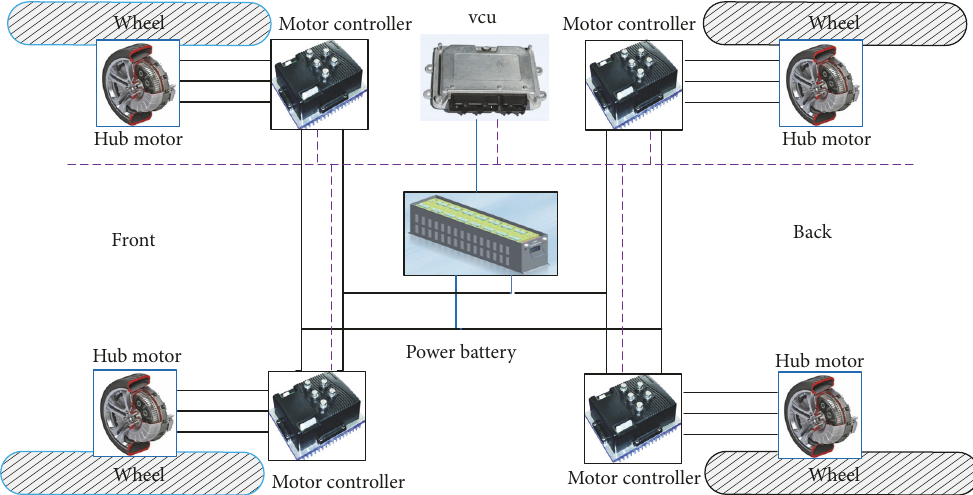
Figure 1: System diagram of a distributed drive electric vehicle.